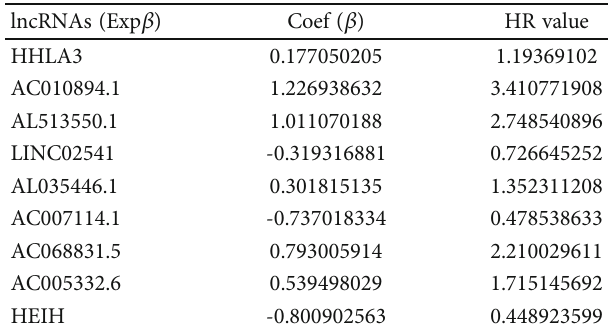
Table 2: Coe ffi cient pro fi les of the nine m7G-related prognostic lncRNAs.